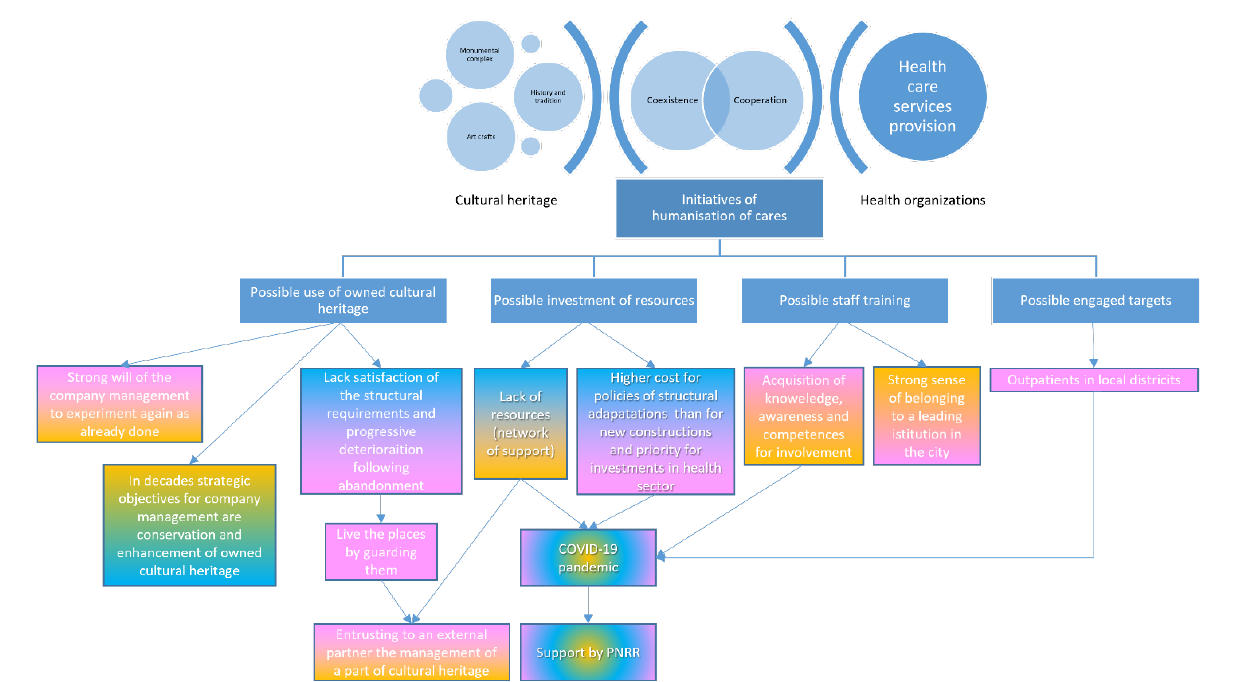
Figure 2. Coding process illustrating the results of the Santo Spirito in Sassia hospital case (general management in yellow, cultural heritage management in blue, health management in pink).